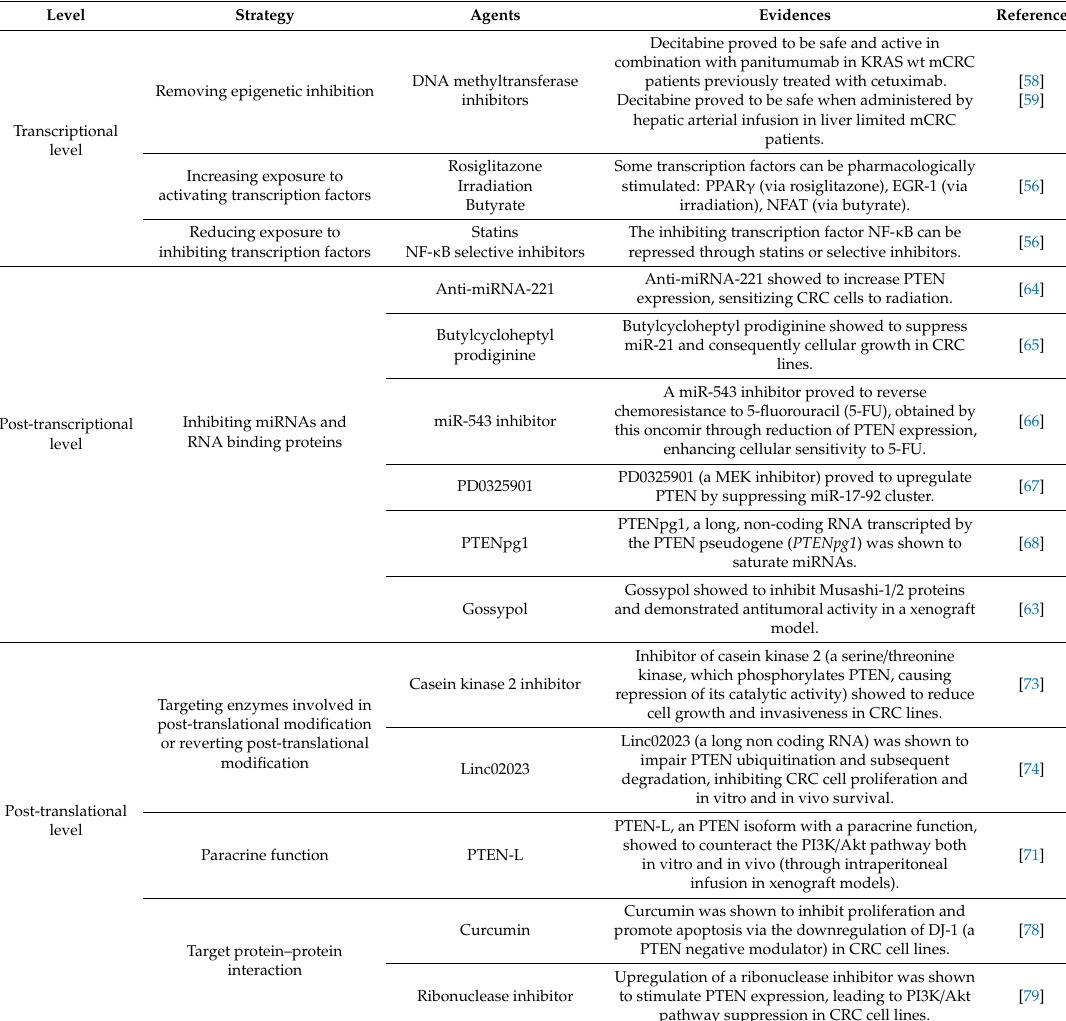
Table 2. PTEN as a target. Strategies aiming at restoring PTEN onco-suppressor functions that have been hypothesized and are currently under evaluation in early phases of research in preclinical